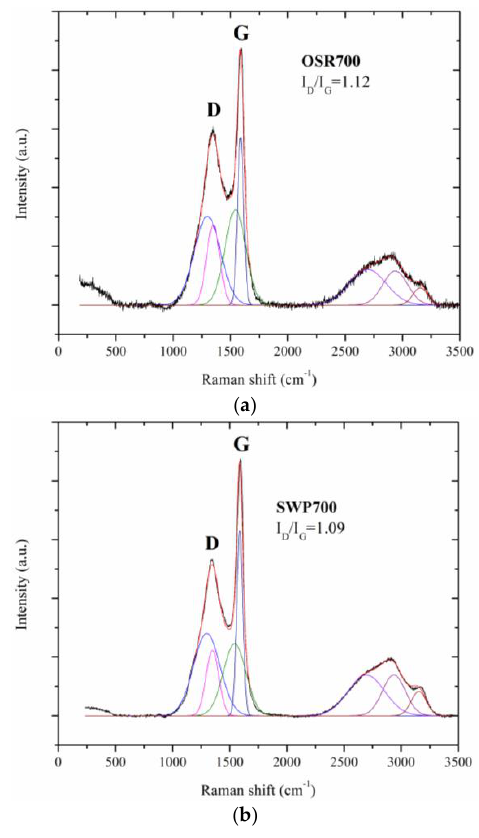
Figure 5. Raman spectra for ( a ) OSR700; ( b ) SWP700.